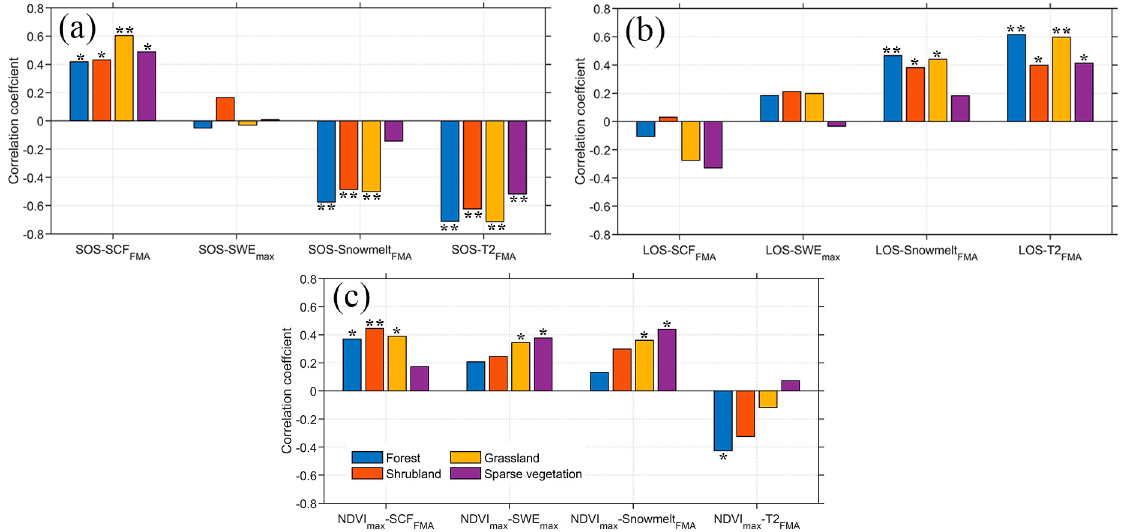
Figure 7. Correlation coefficients between ( a ) SOS, ( b ) LOS, and ( c ) NDVI max and SCF FMA , SWE max , Snowmelt FMA , and T2 FMA for each type (* and **indicate p < 0.05 and p < 0.01, respectively).